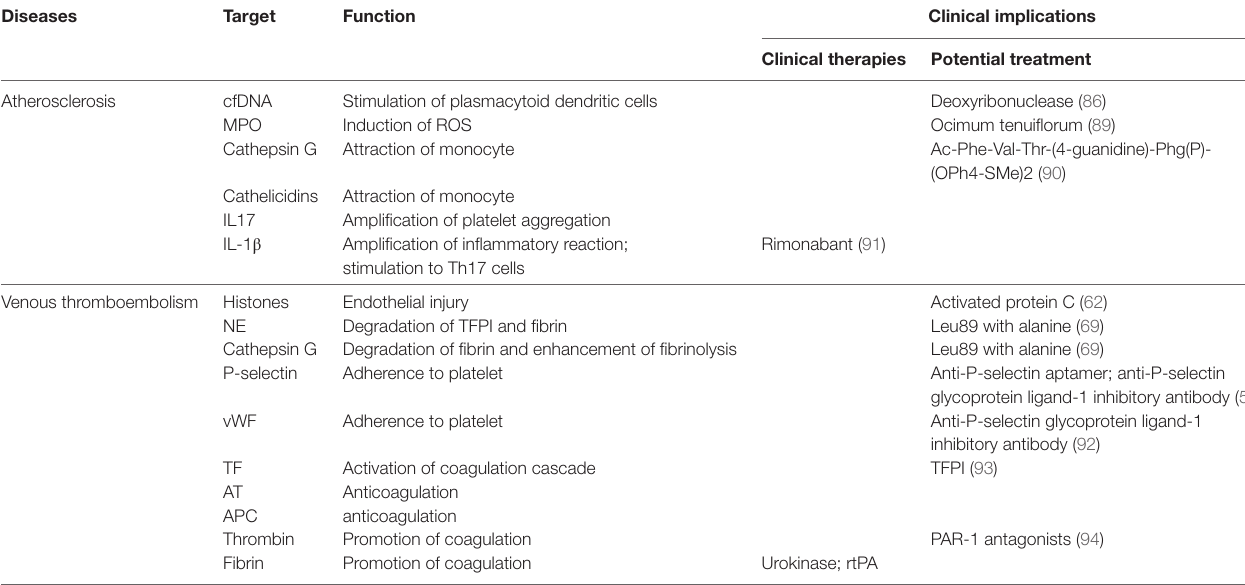
TABLe 1 | Potential targets for translation in the prevention of NET-mediated atherosclerosis and